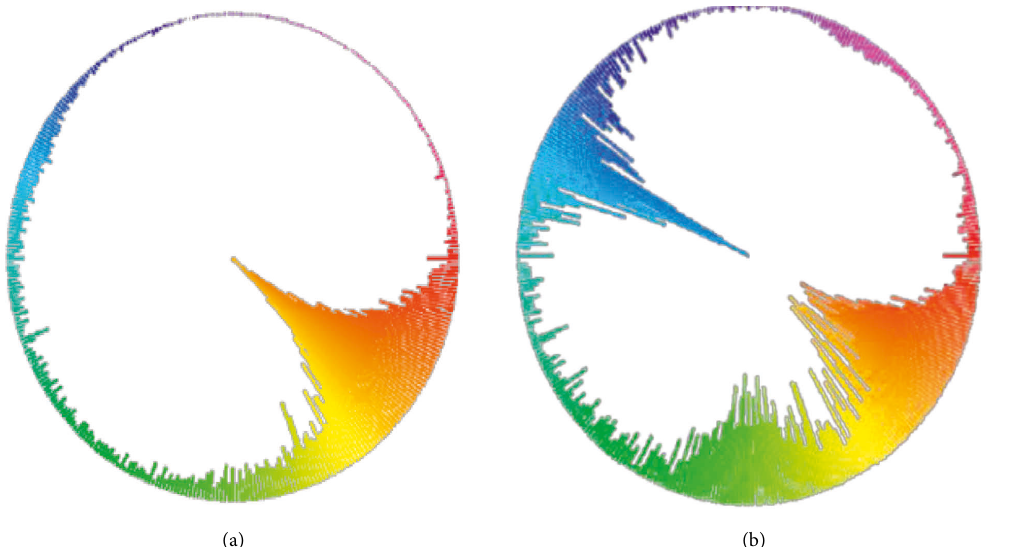
Figure 6: Color distribution map. (a) Oil painting. (b) Natural images.